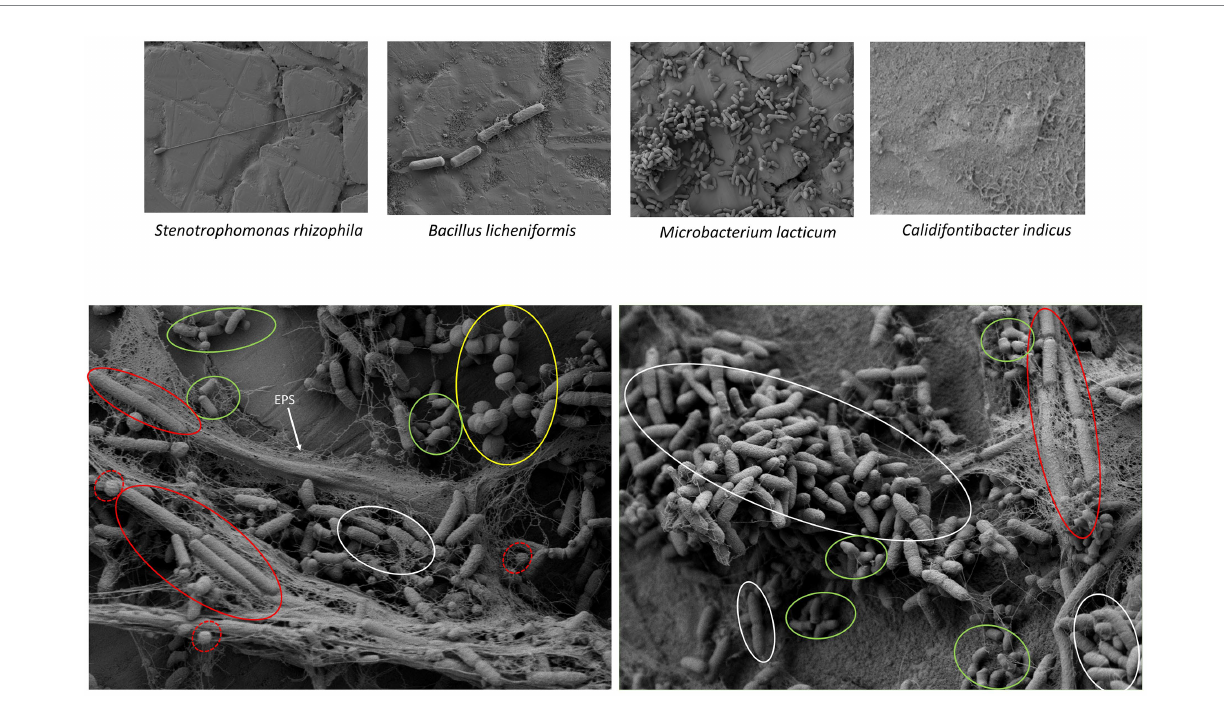
FIGURE 8 Scanning electron microscopy images of the synergistic biofilm formed by four species of the dairy origin: Stenotrophomonas rhizophila (S2), Microbacterium lacticum (S1), Calidifontibacter indicus (S1), and Bacillus licheniformis . The presence of all these four species was confirmed in SEM images and they are highlighted with circles of white, green, yellow, and red colors, respectively. B. licheniformis spores are also shown in dotted circle of red color. The first part of the figure shows monospecies biofilms of all species that were present in this selected four-species biofilm